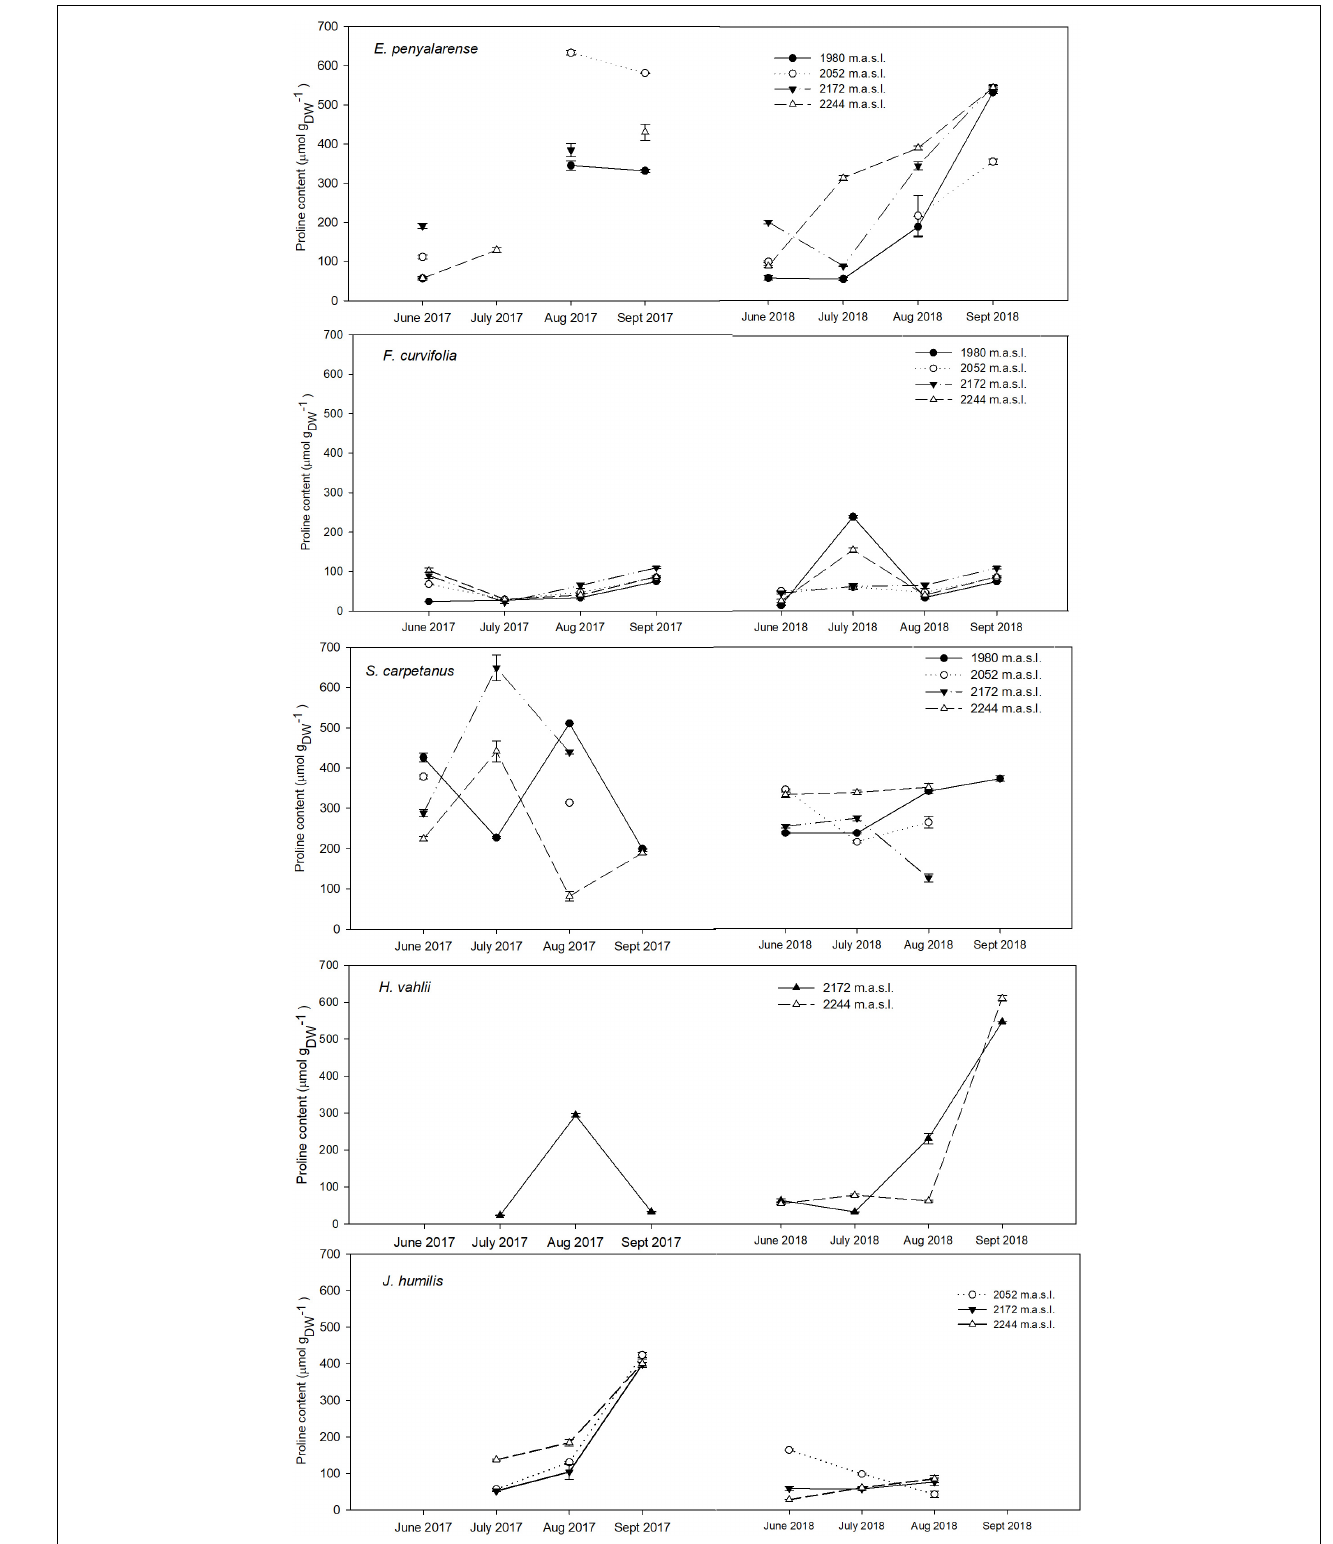
FIGURE 3 | Seasonal variation in Pro content in hemicryptophytes E. penyalarense , F. curvifolia , S. carpetanus , H. vahlii, and J. humilis in both years of study (2017, 2018) throughout the elevation gradient. For each sampling event, n = 10.